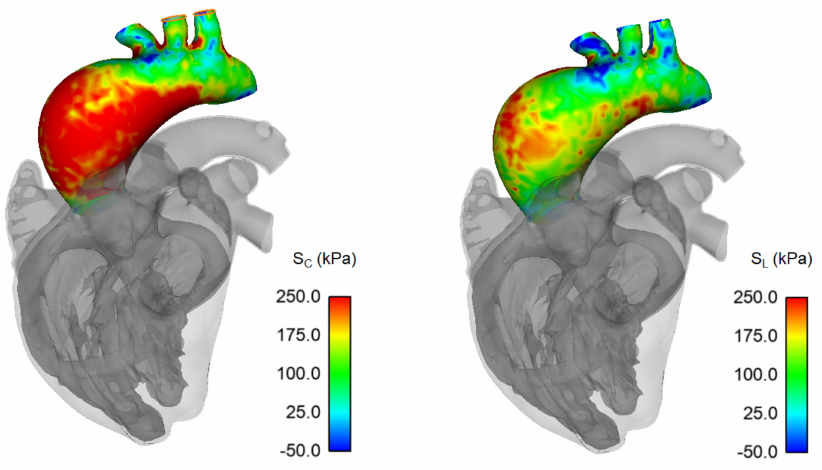
Figure 5. Circumferential ( S C ) and longitudinal stress ( S L ) map during systolic peak for ATAA